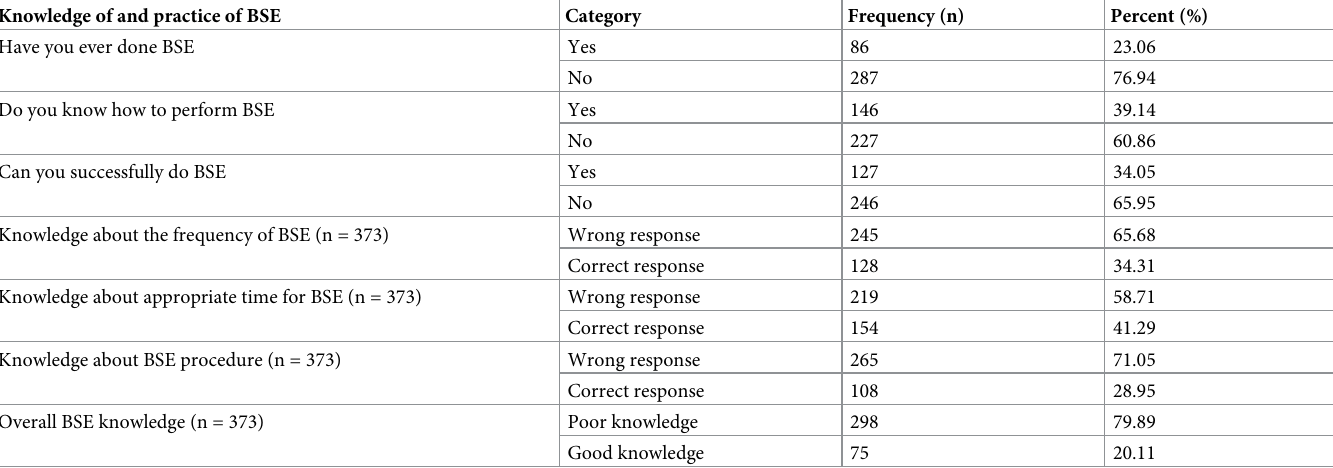
Table 4. Young adult women’s BSE knowledge and practice, Gurage Zone.